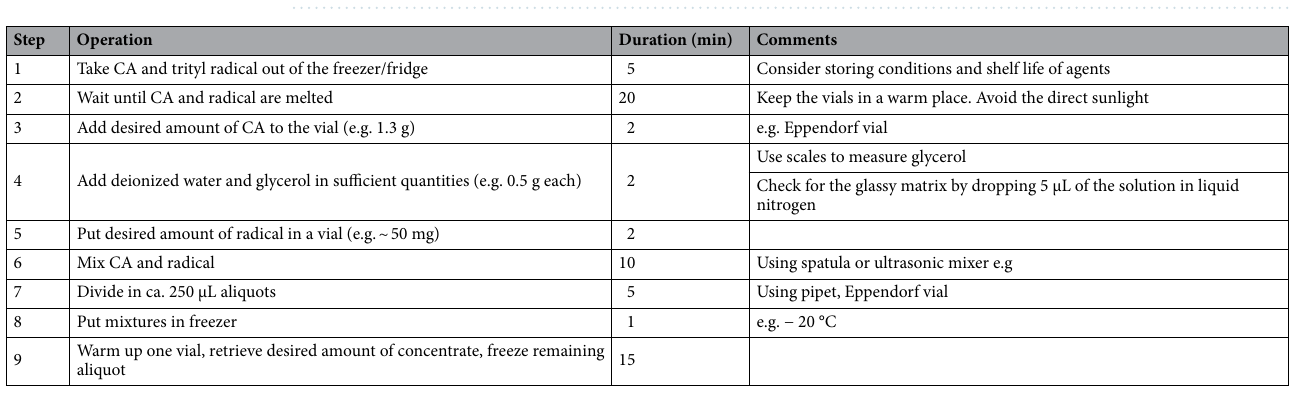
Figure 2. Drawings of the dDNP system indicating the dimension, stray magnetic field (dashed lines) and operator area (red line). (Drawings are reproduced from SpinAligner User Manual with permission).